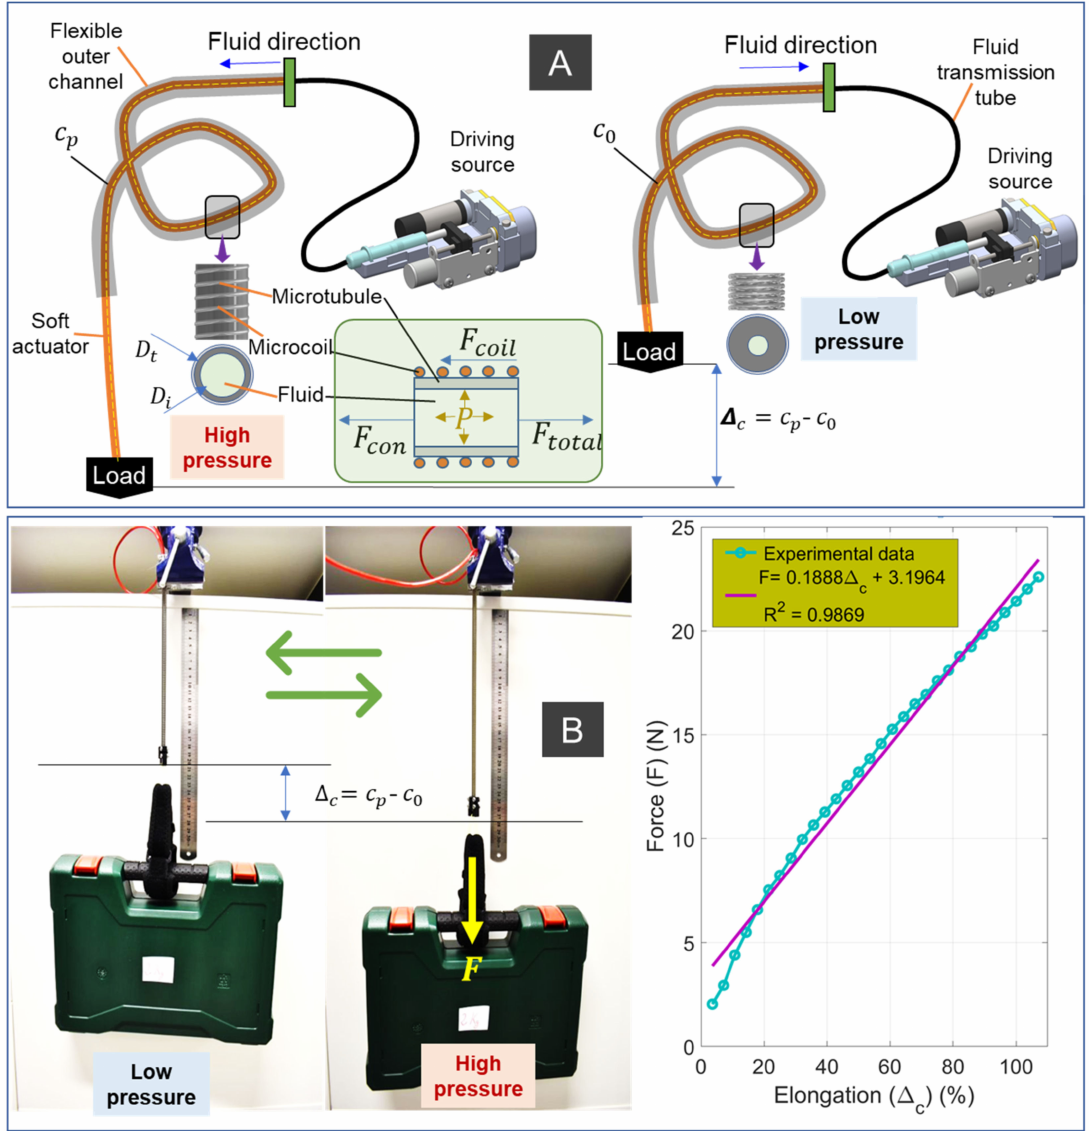
Figure 2. The soft actuator (SA). ( A ) Its working principle when it slides inside a hollow channel and pressure P distribution. ( B ) Lifting performance of SA1 (see Table 1, weight of 50 g, outer diameter of 6.35 mm, length of 200 mm), without a flexible outer channel against a load of 2 kg (left panel) and the relation between the elongation and generated contraction force (right